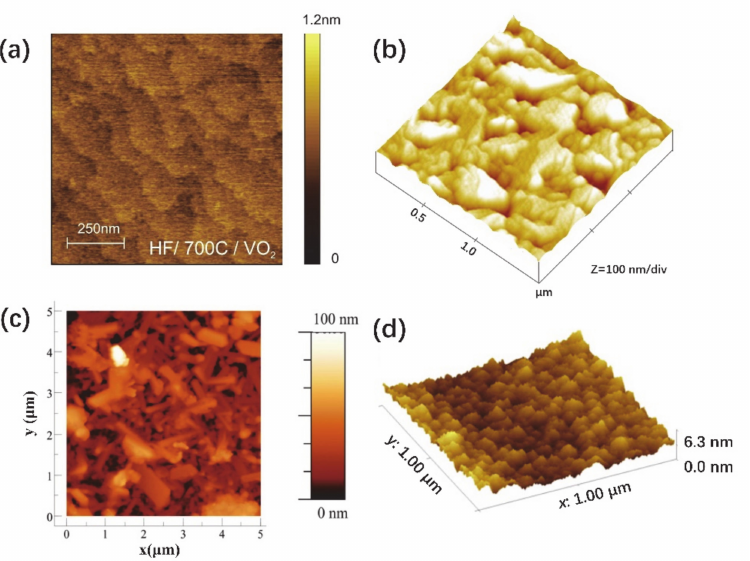
Figure 13. AFM images of VO 2 thin film grown on different substrates. ( a ) Rutile TiO 2 substrates. Reproduced from [88], with permission from AIP Publishing, 2014. ( b ) Al 2 O 3 substrate. Reproduced from [90], with permission from AIP Publishing, 2011. ( c ) Glass substrate. Reproduced from [92], with permission from Elsevier, 2017. ( d ) Si/SiO 2 substrate. Reproduced from [93], with permission from AIP Publishing,